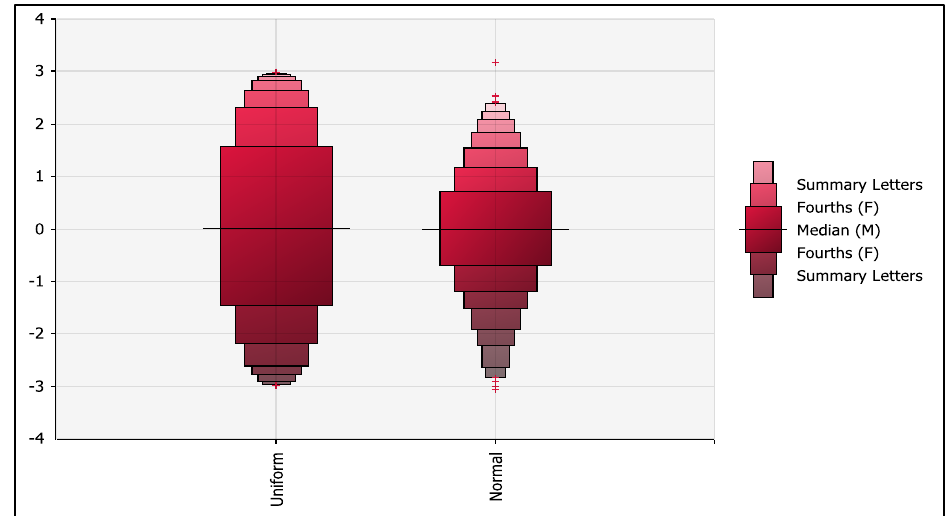
Figure 1. Letter value plot for uniform distribution in the range [ − 3, +3] and standardized normal distribution (source: own study).